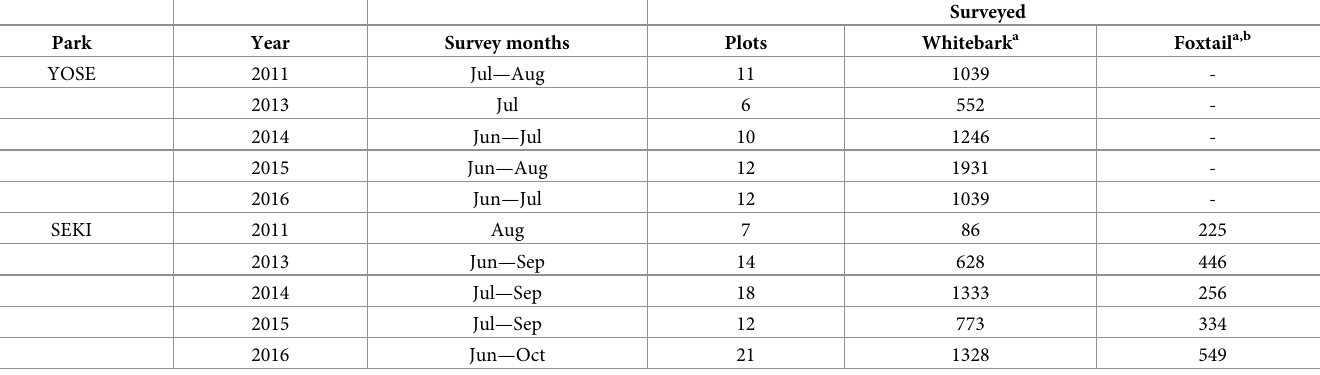
Table 2. Whitebark and foxtail pine surveys conducted in Yosemite National Park (YOSE) and Sequoia and Kings Canyon National Parks (SEKI), both within the Sierra Nevada Inventory and Monitoring Network (SIEN). These data were used for spatial